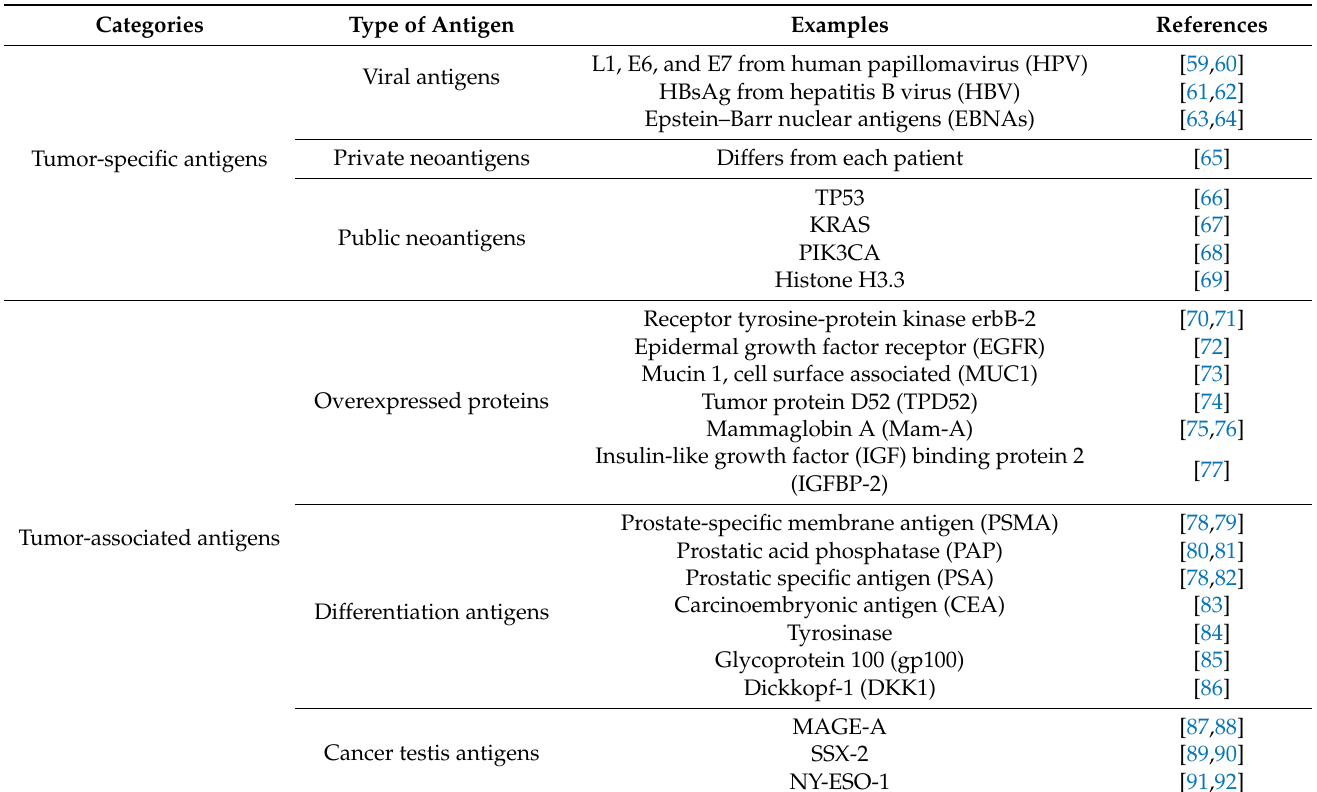
Table 1. Classification of tumor